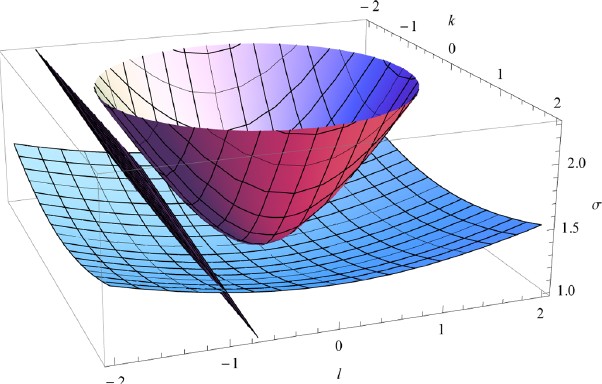
Fig. 2. Dispersion relation σ(k,l) for the waves in the 2-layer sys- tem at r = 0 . 5. Upper surface: barotropic IG waves, lower surface: baroclinic IG waves. Inclined plane: barotropic Kelvin waves. An inclined plane with lesser slope, corresponding to the baroclinic Kelvin waves, is not displayed beneath the dispersion surface for baroclinic IG, to avoid overcharging the